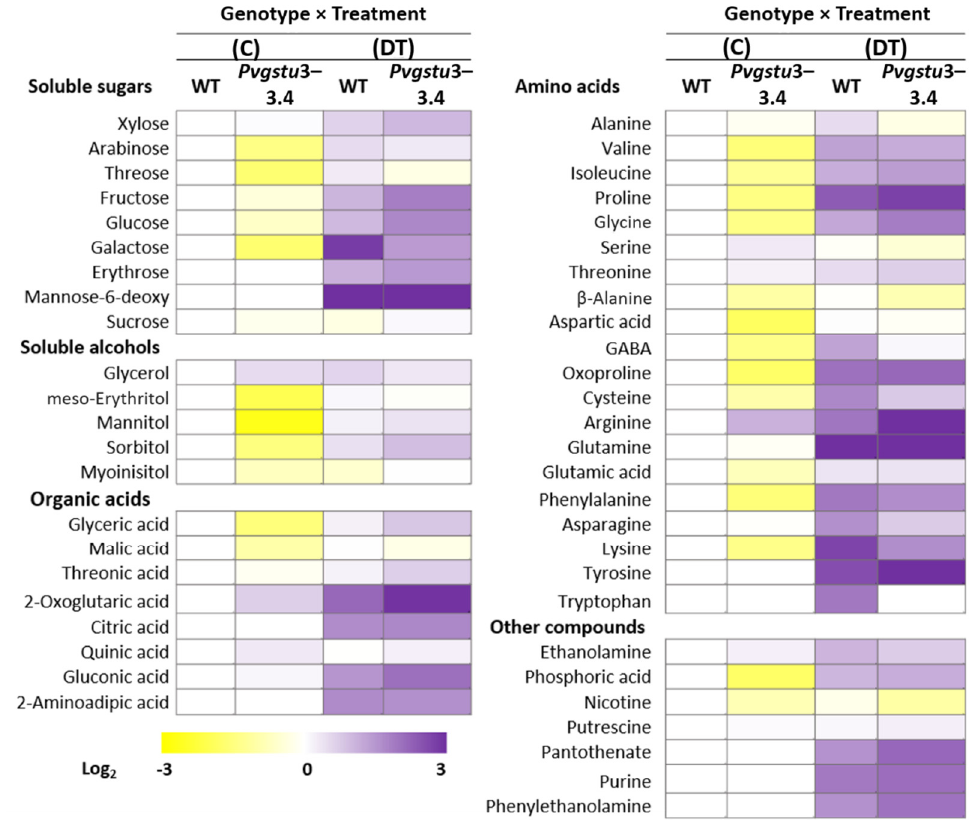
Figure 6. Heat map of primary metabolites of Pvgstu3–3.4 and WT plants under combined DT stress (9 days) compared to control conditions. For each metabolite, the ratio between DT treatment to control was transformed into log2 and depicted with a color scale indicated as purple (increase) and as yellow (decrease; see color scale). Mean values of three independent determinations for each treatment were expressed as relative abundance compared to internal standard adonitol and are reported as background-free of the control conditions at 0 days. Actual data are provided in Supplementary Table S6.